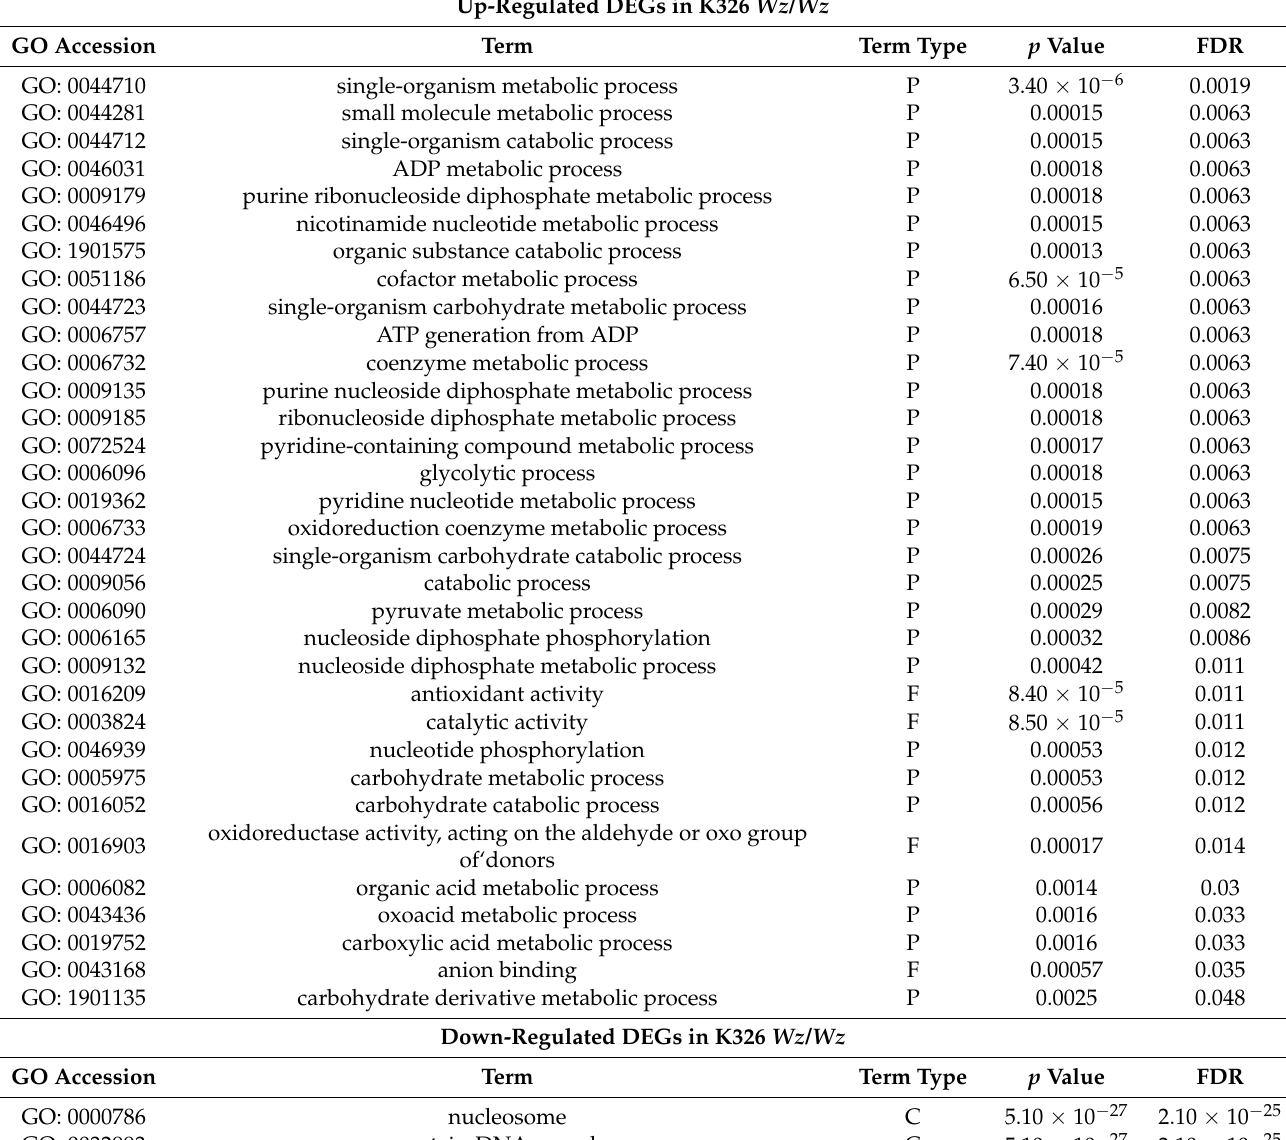
Table 8. GO terms enriched for DEGs exclusively identified in K326 Wz/Wz inoculated with the Wz-Wz isolate. Up-Regulated DEGs in K326